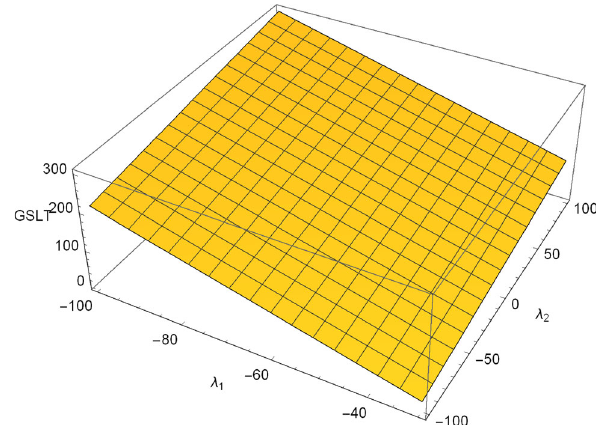
Fig. 7 Validity of GSLT for logarithmic corrected entropy with con- stant Hubble